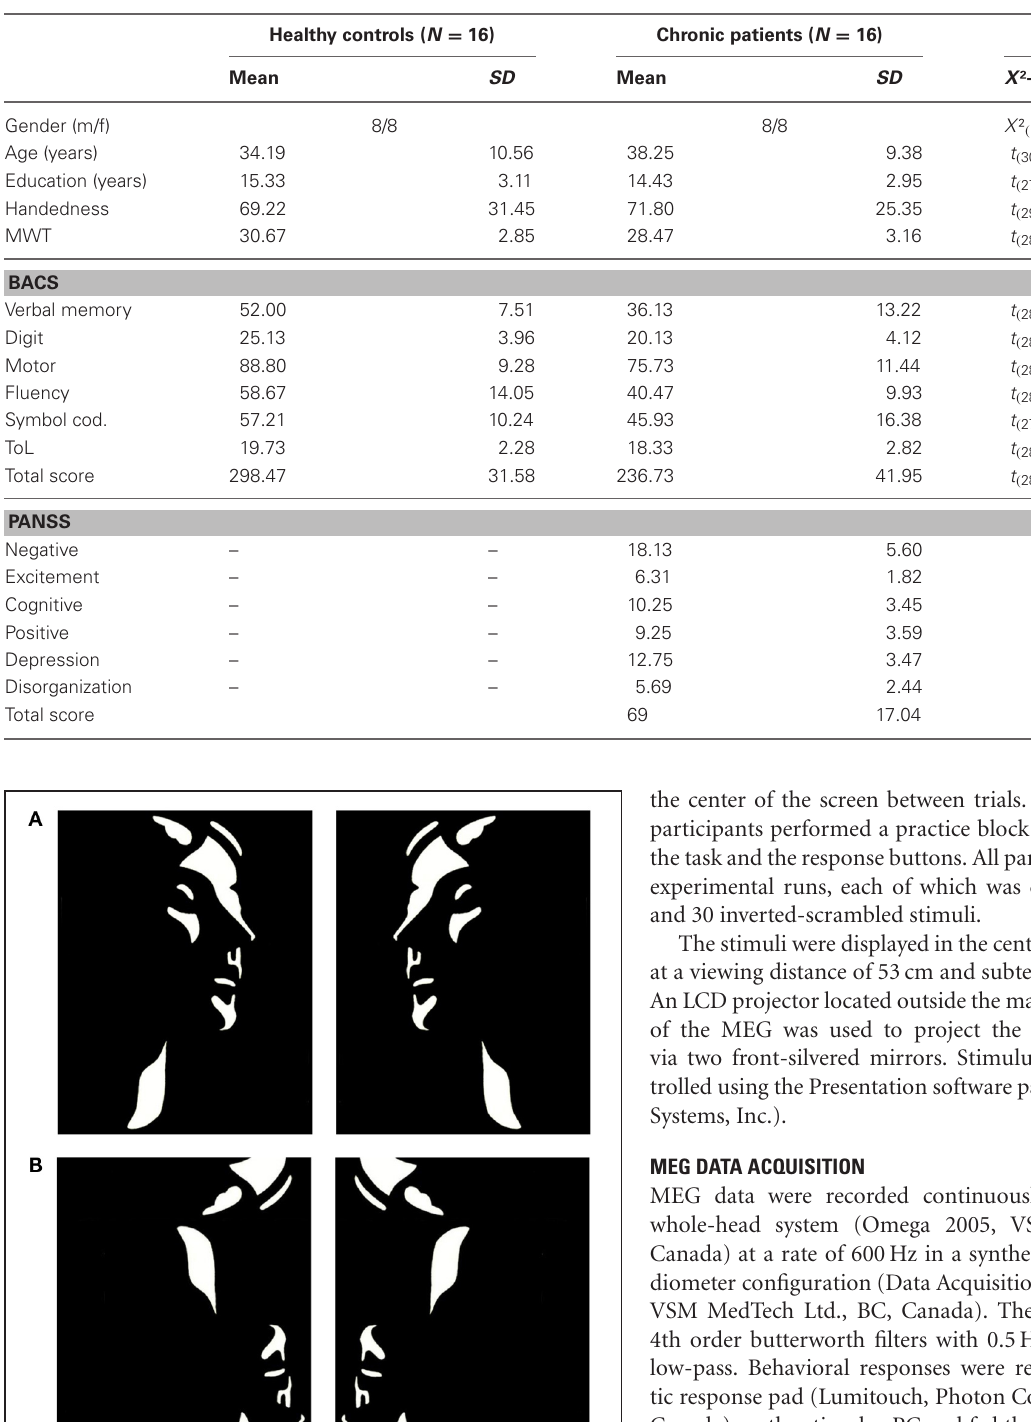
Table 1 | Means, standard deviations, and mean differences for demographic, neurocognitive, and clinical characteristics of controls and schizophrenia patients.